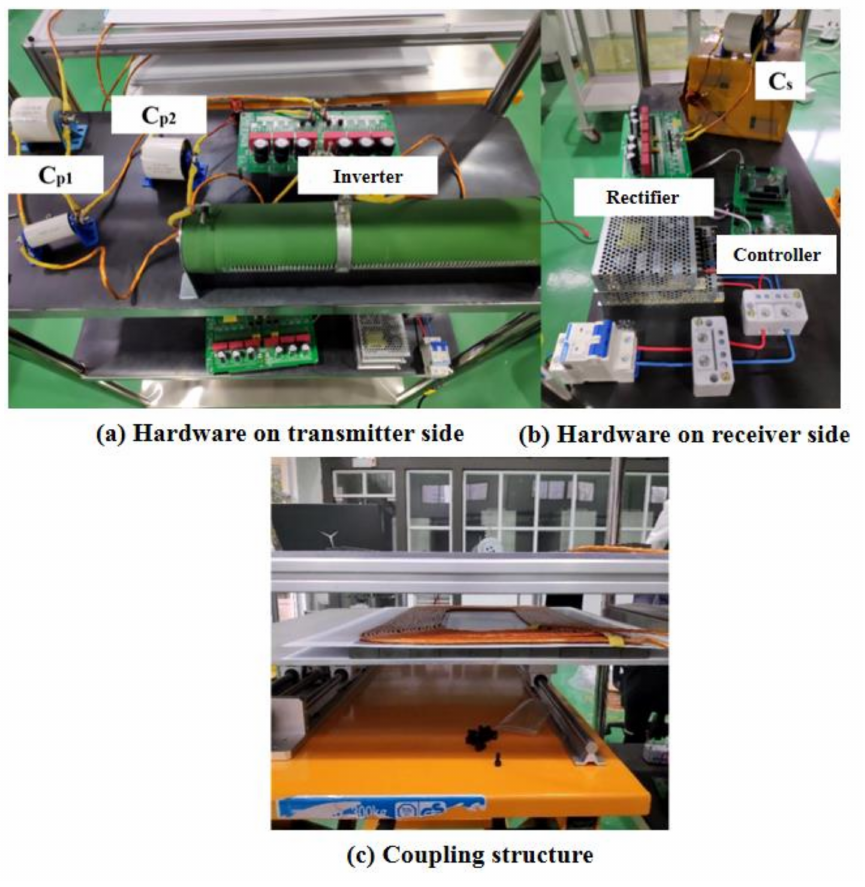
Figure 11. Experimental platform. Table 1. Experimental